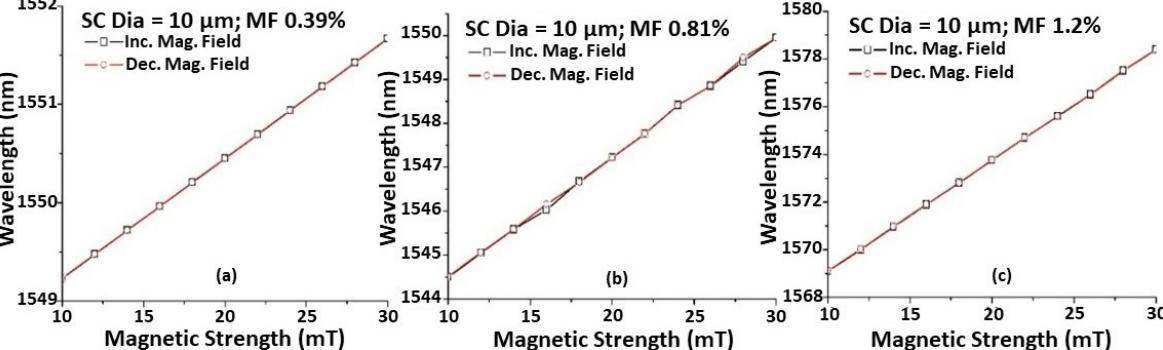
Figure 3. Wavelength shift caused by the change in magnetic field for STS CS of 10 μm tapered waist diameter encapsulated in ( a ) 0.39%, ( b ) 0.81%, and ( c ) 1.2% FMPs in MF.